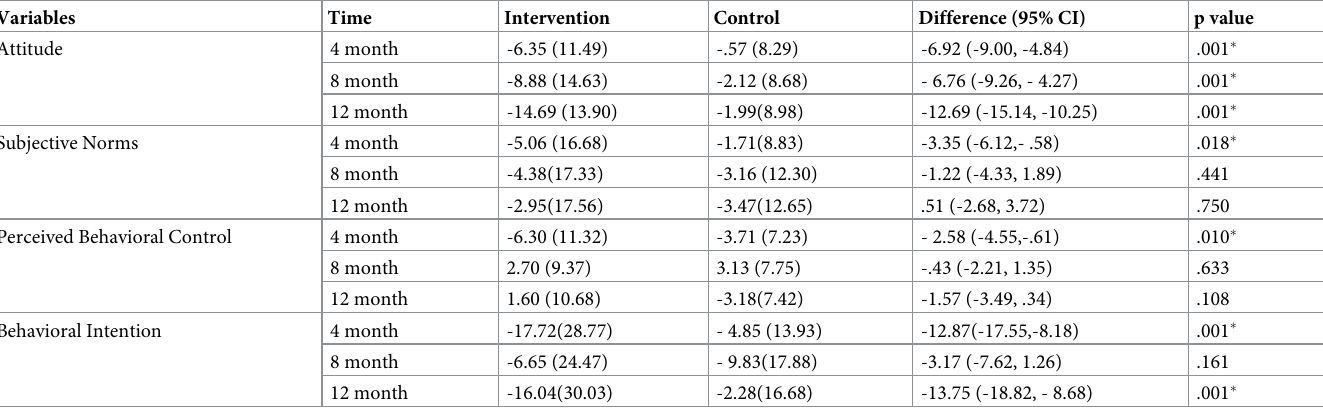
Table 7. Mean changes in constructs of theory of planned behavior intent to perform mammography by time and group (n = 360).